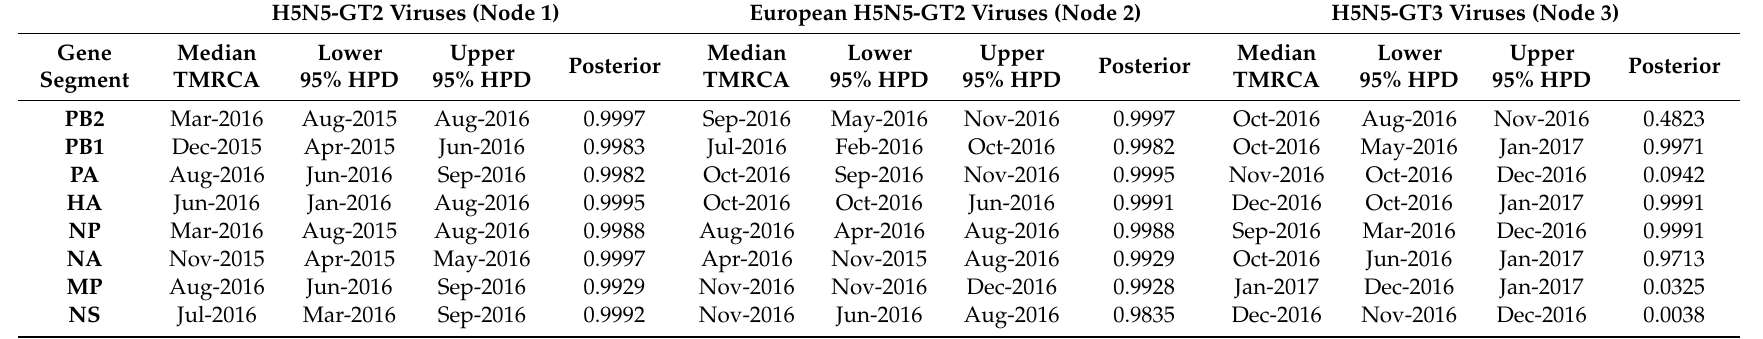
Table 2. Time to the most recent common ancestor (TMRCA) estimates of HPAI H5N5 genotypes. Estimated median TMRCA for each gene segment of highly pathogenic avian influenza (HPAI) H5N5 viruses of genotype H5N5-GT2, the European H5N5-GT2 viruses and H5N5-GT3 viruses with 95% highest posterior density (HPD) intervals. The nodes for which the median TMRCAs estimates were determined are depicted in the time-scaled phylogenetic trees in Figure S3. PB2, polymerase basic protein 2; PB1, polymerase basic protein 1; PA, polymerase acidic protein; HA, hemagglutinin; NP, nucleoprotein; NA, neuraminidase; MP, matrix protein; NS, nonstructural